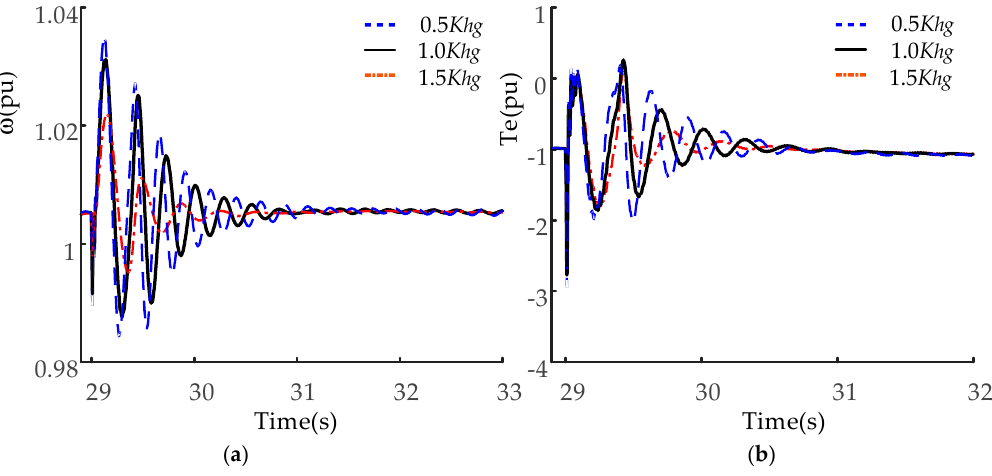
Figure 16. Impact of the three-phase ground fault for different spring constants K hg ( a ) Rotational speed ( b ) Electromagnetic torque.